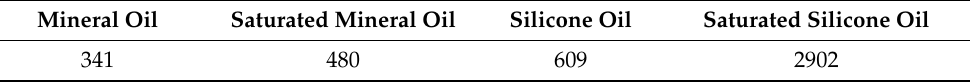
Table 2. Values of the moisture content of oils in ppm as measured by Karl Fischer